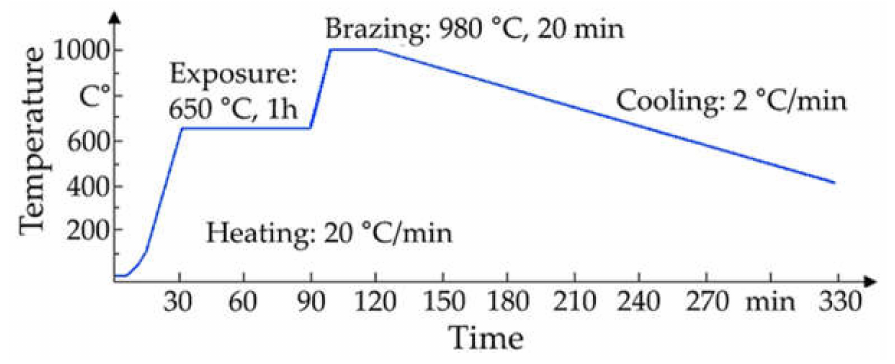
Figure 3. Time–temperature brazing